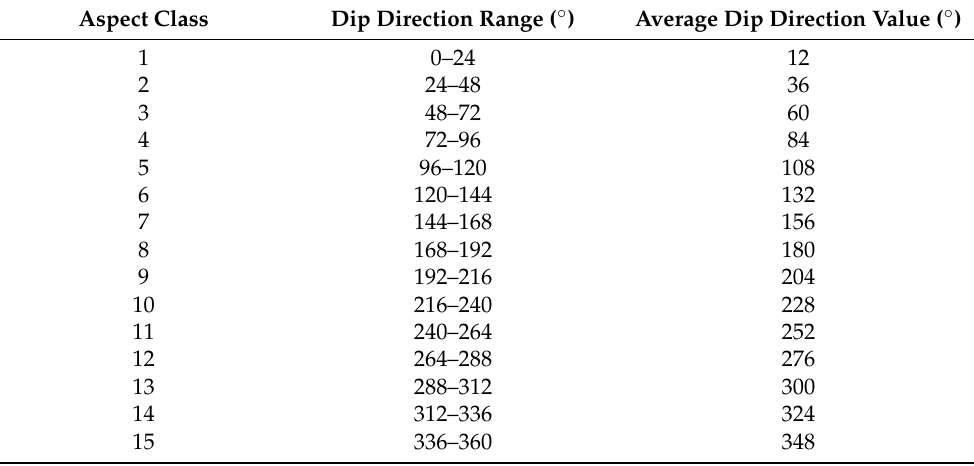
Figure 4. Q-slope stability graph and PoF equations, modified from [54]. Table 1. Classes of Aspect with indication of dip direction range and average